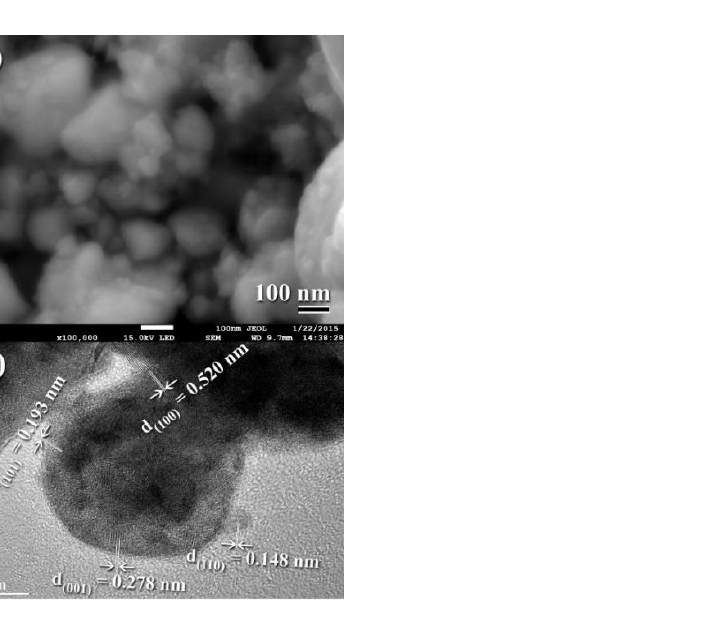
Figure 21. XRD patterns of starting hcp-WC powders after ( a ) 0, ( b ) 3, and ( c ) 15 h mechanical milling. The particles were milled for 20 h and then consolidated at 1250 °C using the SPS method ( d ). The XRD patterns of WC powders that have been ball milled and then mechanically mixed with 7% (10Co/4Cr) powders for 0, 6, 12.5, and 25 h are shown in ( e ), ( f ), ( g ), and ( h ). The XRD pattern of powders containing 93-WC/7 wt. % (10Co/4Cr) produced after 50 h and subsequently consolidated at 1250 °C using the SPS method is given in ( i ).